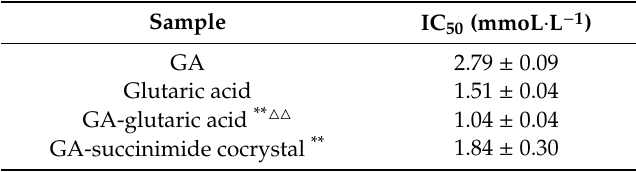
Figure 4. Inhibition activities of GA, CCF and cocrystals on α -glucosidase ( A ) GA-glutaric acid cocrystal system; ( B ) GA-succinimide cocrystal system. * p < 0.05, ** p < 0.01 compared with GA. Table 1. Activities of GA, glutaric acid and